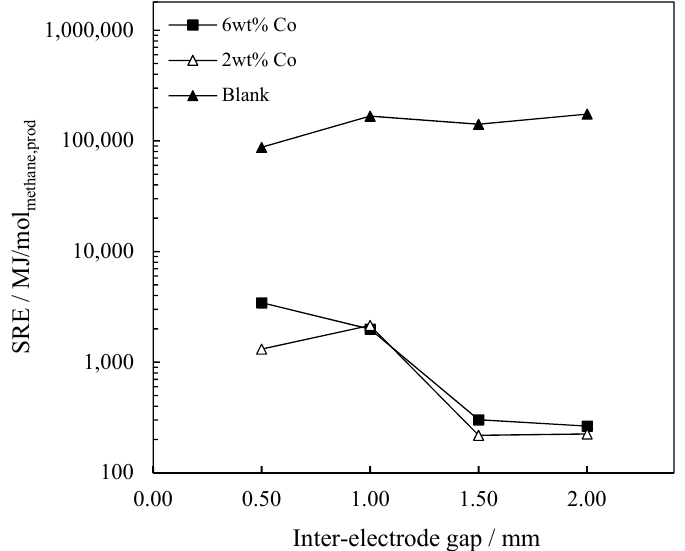
Figure 14. Specific required energy (MJ/molmethane,prod) as a function of inter-electrode gap for plasma-catalytic FTS (NTP + Blank, 2 or 6 wt% Co catalyst) at a discharge time of 60 s. Legend: ■ —6 wt% Co; Δ —2 wt% Co; ▲ —Blank. Operating conditions: Syngas (H 2 /CO) ratio: 2.2:1; pressure: 2 MPa; current: 350 mA; wall temperature: 25 °C.